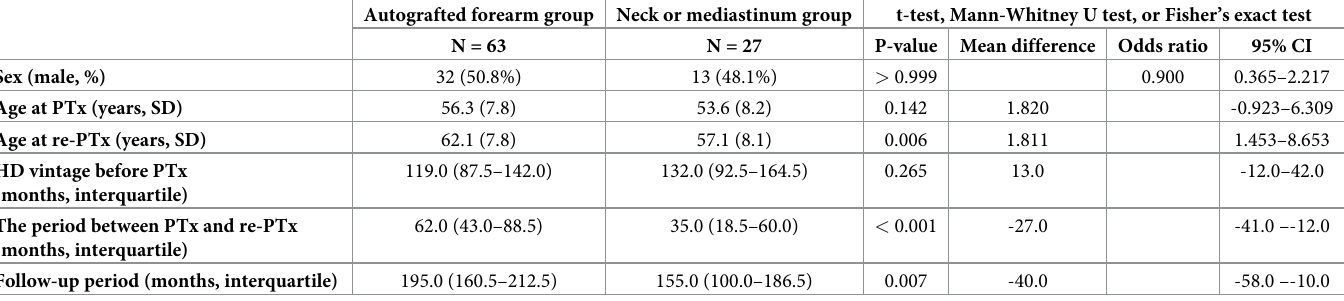
Table 1. Patient